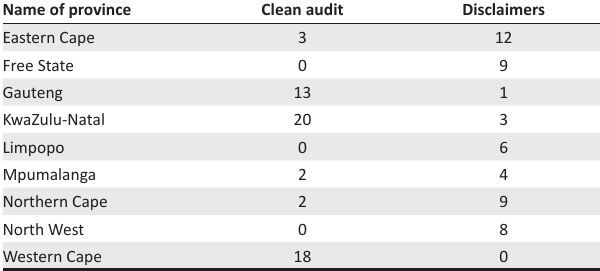
TABLE 2: Clean audits and persistent disclaimers per province (2013–2014 financial year).